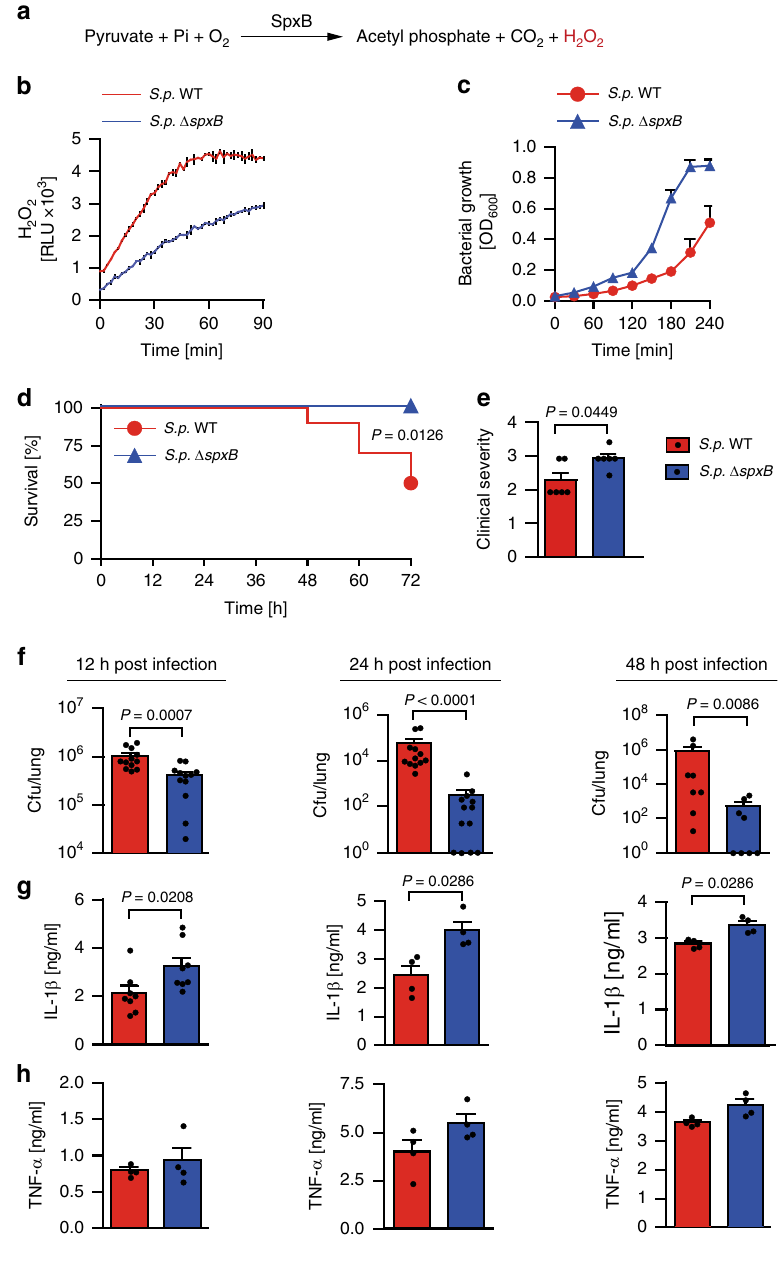
Fig. 1 Pyruvate oxidase SpxB dampens in fl ammasome-dependent cytokine response promoting S. pneumoniae survival. a The pyruvate oxidase (SpxB)- mediated H 2 O 2 generation reaction in S. pneumoniae . b H 2 O 2 release by wild-type S. pneumoniae D39 ( S.p . WT) and S.p . Δ spxB . c In vitro growth rate of S.p . WT (D39) and S.p . Δ spxB . b and c are representative of 3 independent experiments performed in triplicates; data shown as mean ± standard